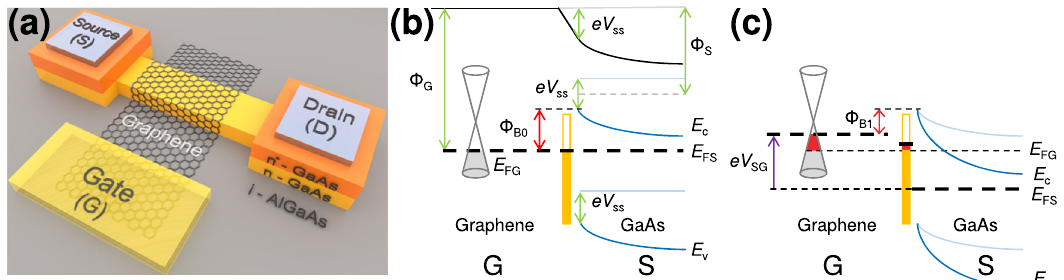
Fig. 1 Standard (single-gate) GESFET. a A schematic of a standard GESFET fabricated on an intrinsic GaAs/AlGaAs substrate (orange/yellow/ gray) epitaxially grown by molecular-beam epitaxy (MBE). The graphene gate (gray with hexagonal pattern) was transferred on top of the n-GaAs transistor channel (yellow) and was externally accessed through the Au gate pad (transparent yellow). The source and drain contacts (lavender) were evaporated on an n + -GaAs layer (orange) to create an ohmic contact with the n-GaAs channel. b The equilibrium band diagram of a GESFET in the vertical direction, i.e., from the graphene gate (G) to surface states (orange bar) and n-GaAs channel (S). The Fermi level in graphene ( E FG ) is equal to the Fermi level in the channel ( E FS ) at V GS = 0 V. The work function of the graphene gate and channel are Φ G